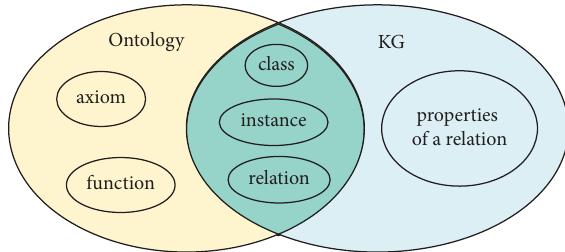
Figure 1: Te relationship between an ontology model and a